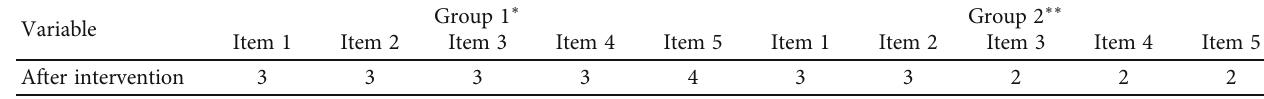
Table 2: PHE scale score changes after the intervention in the group 1 and group 2.